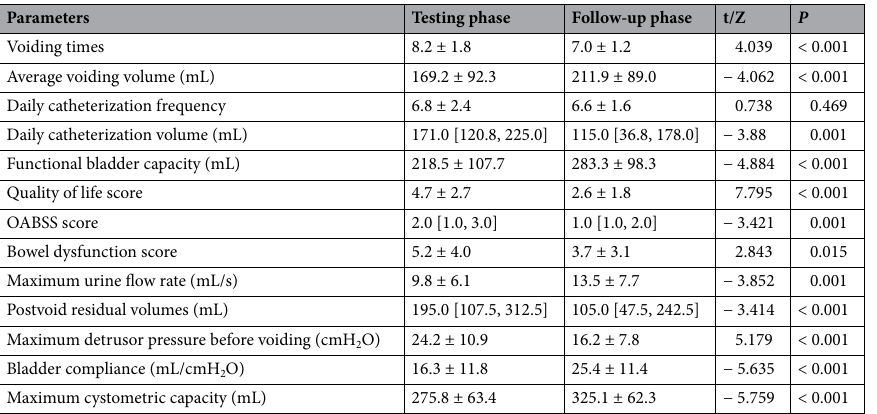
Table 3. Comparison of data from testing phase and follow-up phase of 38 patients with NB who underwent SNM permanent electrode implantation. OABSS overactive bladder symptom scale.